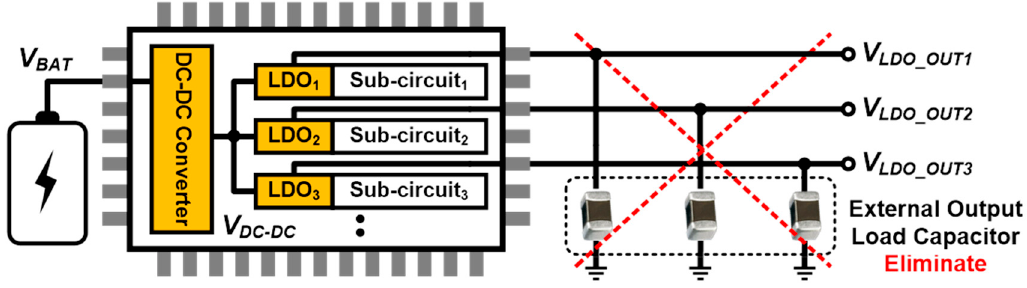
Figure 1. Power management integrated circuit (PMIC) with output capacitor-less low dropout regulator (OCL-LDO) scheme.